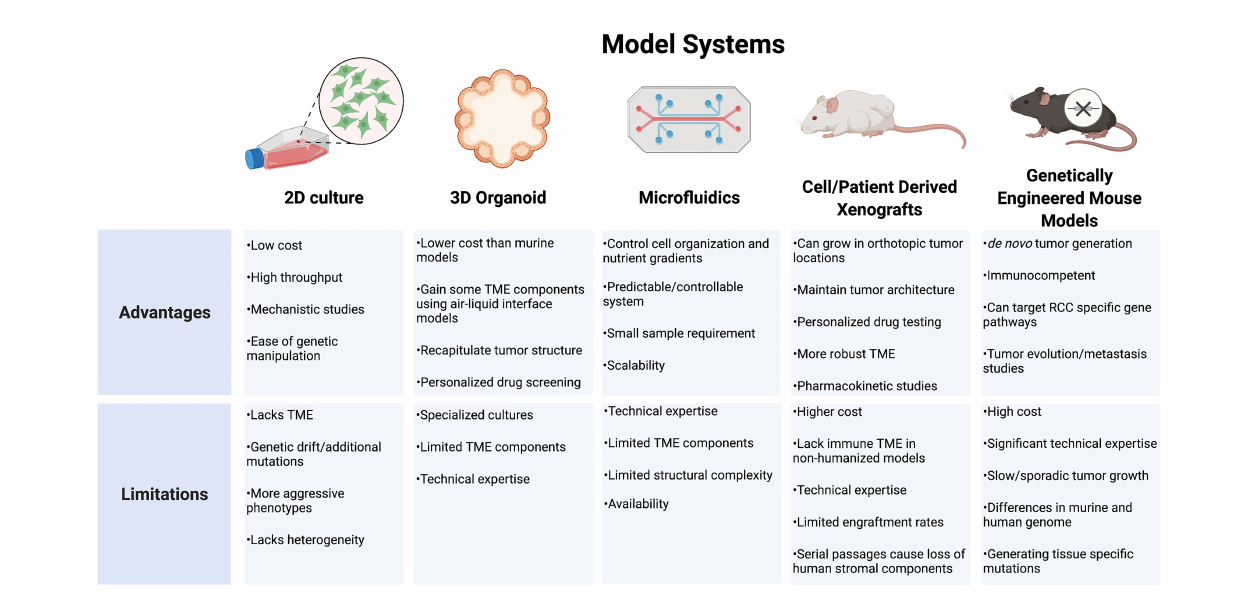
FIGURE 4 | Model systems used for renal cell carcinoma research. TME, tumor microenvironment; RCC, renal cell